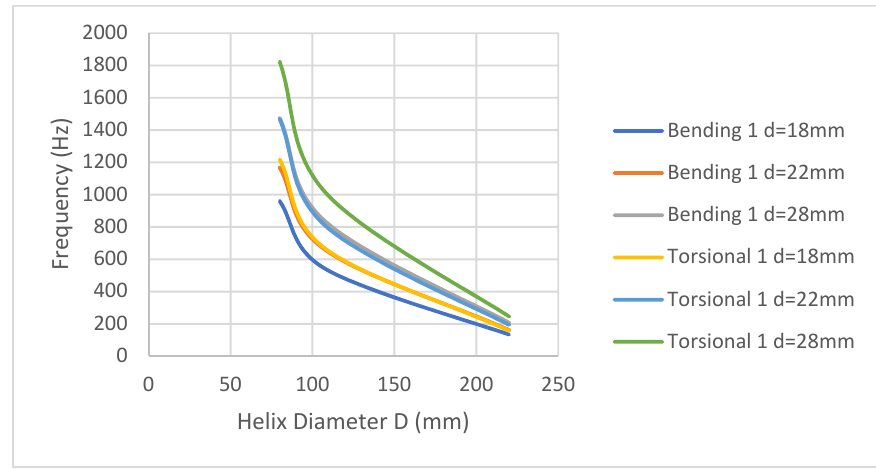
Figure 10. Sensitivity of the first resonance modes to the helix diameter, D.